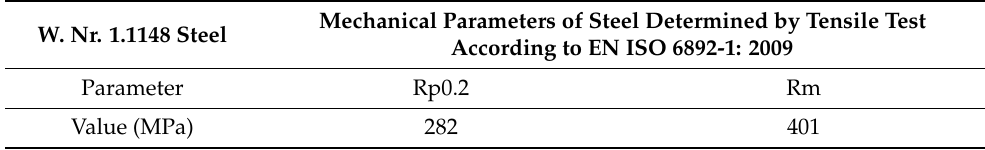
Table 2. Real mechanical parameters of W. Nr. 1.1148.